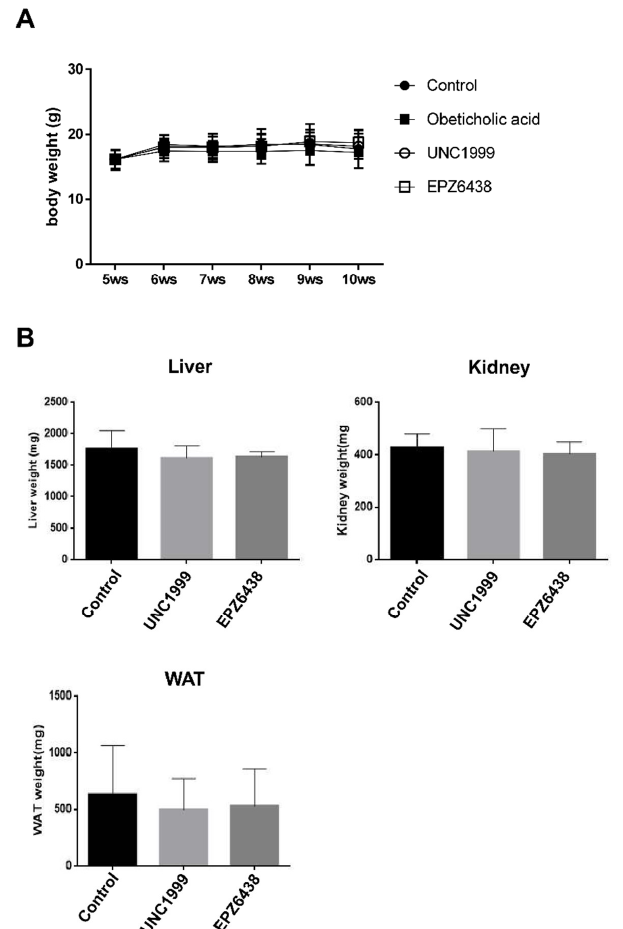
Figure 2. Treatment with EZH2 inhibitors has no effect on body weight in STAM NASH mice. ( A ) Effect of EZH2 inhibitors (UNC1999, EPZ-6438) and obeticholic acid on body weight. ( B ) Effect of EZH2 inhibitors on the liver, kidney, and white adipose tissue relative weight. Relative organ weight was measured as the weight of the organ divided by the body weight. Data are shown as mean ± standard deviation (n = 5). Abbreviations: WAT, white adipose tissue.